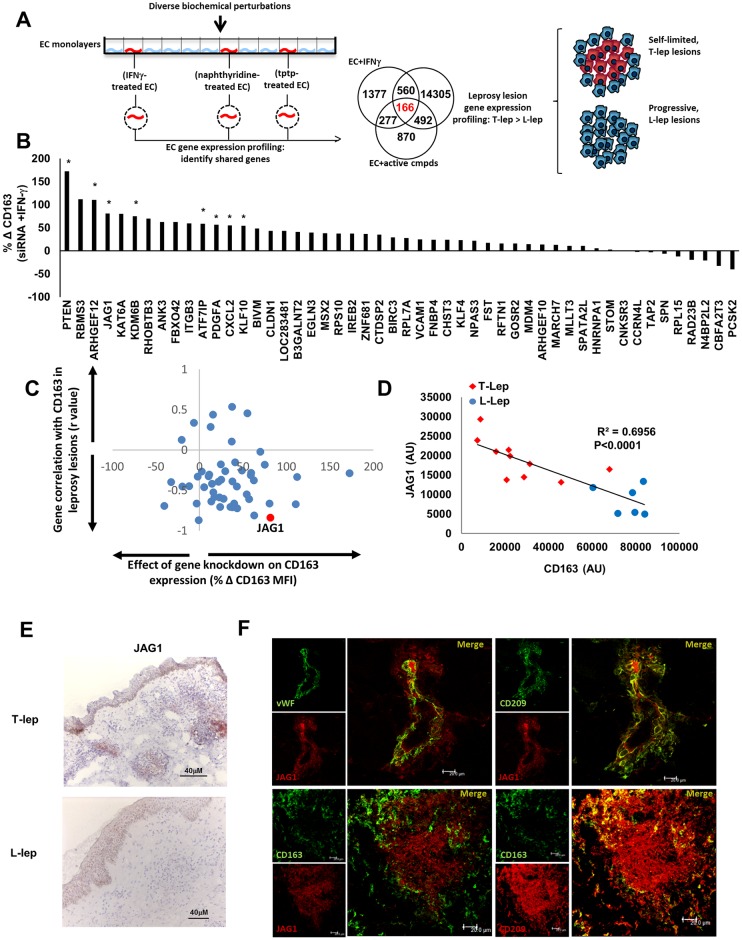
Comparative transcriptome analysis identifies JAG1 as a putative regulator anti-microbial MΦ differentiation in leprosy.(A) Genes induced in EC (FC > 1.25) by IFN-γ, naphthyridines (105 A9 and A10) and tptps (104 B11 and C2) were predicted to contain genes that also influence CD209+MΦ polarization in leprosy. Probes selectively induced (FC> 1.25) by IFN-γ and active compound treatment of the endothelium were integrated with leprosy lesions (T-lep > L-lep, FC 1.25). (B) siRNA knockdown of the top 50 candidate regulatory genes: data represent effect on IFN-γ driven effects on CD163 expression during MΦ differentiation. (* p value < 0.05) (C) The effect of siRNA-mediated candidate gene regulation was correlated with CD163 gene expression in the leprosy data set (T-Lep = 10, L-lep = 6), with JAG1 (D) emerging as a lead candidate regulatory gene. (E) Immunohistochemistry (representative of T-lep, n = 6 and L-lep, n = 4) and (F) confocal microscopy (one lesion, representative of n = 3) localizes JAG1 (IHC-red stain) expression in T-lep lesions with preferential expression in areas with CD209+CD163neg MΦ and the vascular marker vWF.